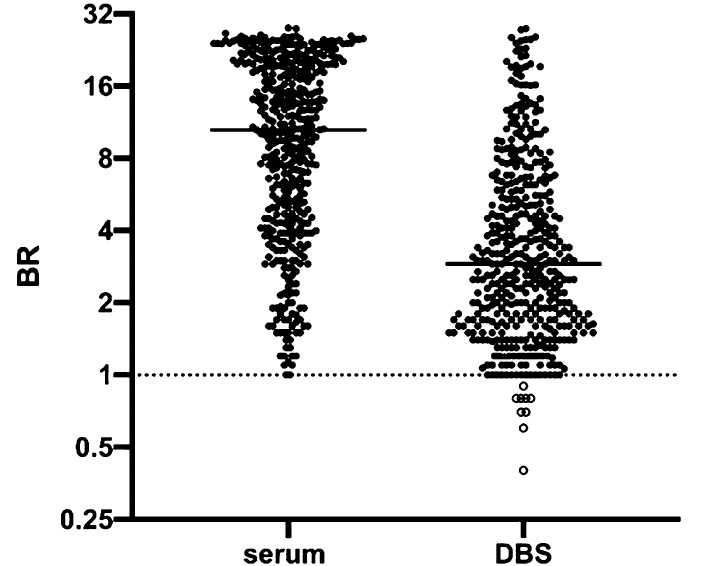
Figure 1. Comparison of Binding Ratios (BR) determined in Hybrid DABA assay using serum and Ig S1 capture assays using DBS eluates. Samples (serum) and DBS (eluates) from 439 sero-positive persons were assayed using the hybrid DABA and S1 IgG and IgM capture assays, respectively. Horizontal line indicates the mean. Binding ratios (BR) from both assays are plotted on a log2 scale with samples from sero-positive individuals shown with filled circles and those from sero-negative individuals shown with empty circles. The dotted line represents the assay cut-off. For 27 individuals, who were IgG negative but IgM positive on DBS eluate, IgM BR are used. Otherwise, IgG BRs are shown.